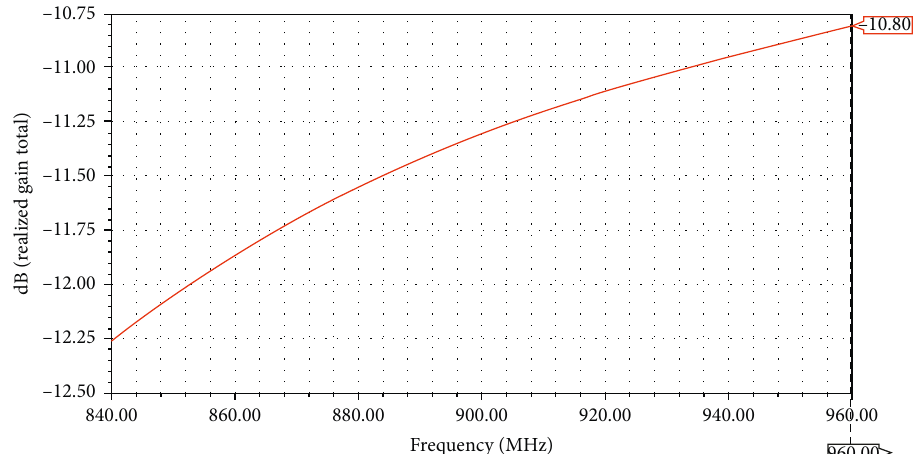
Figure 15: Simulated realized gain of the epidermal double-loop tag with meandered lines in two